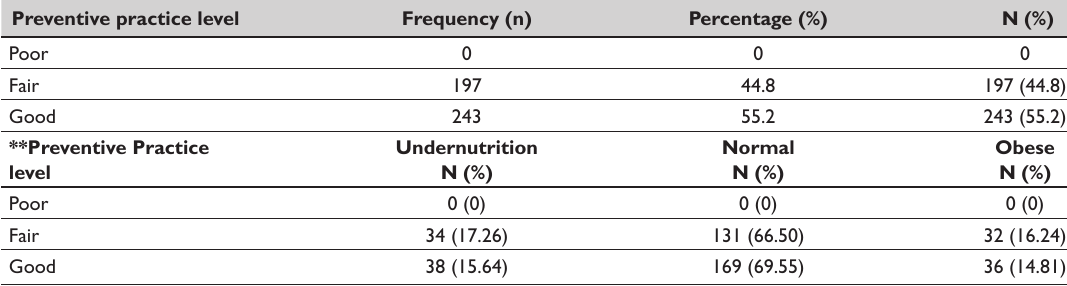
Table 5: Levels of preventive practices of mothers and nutritional status of children Preventive practice level Frequency